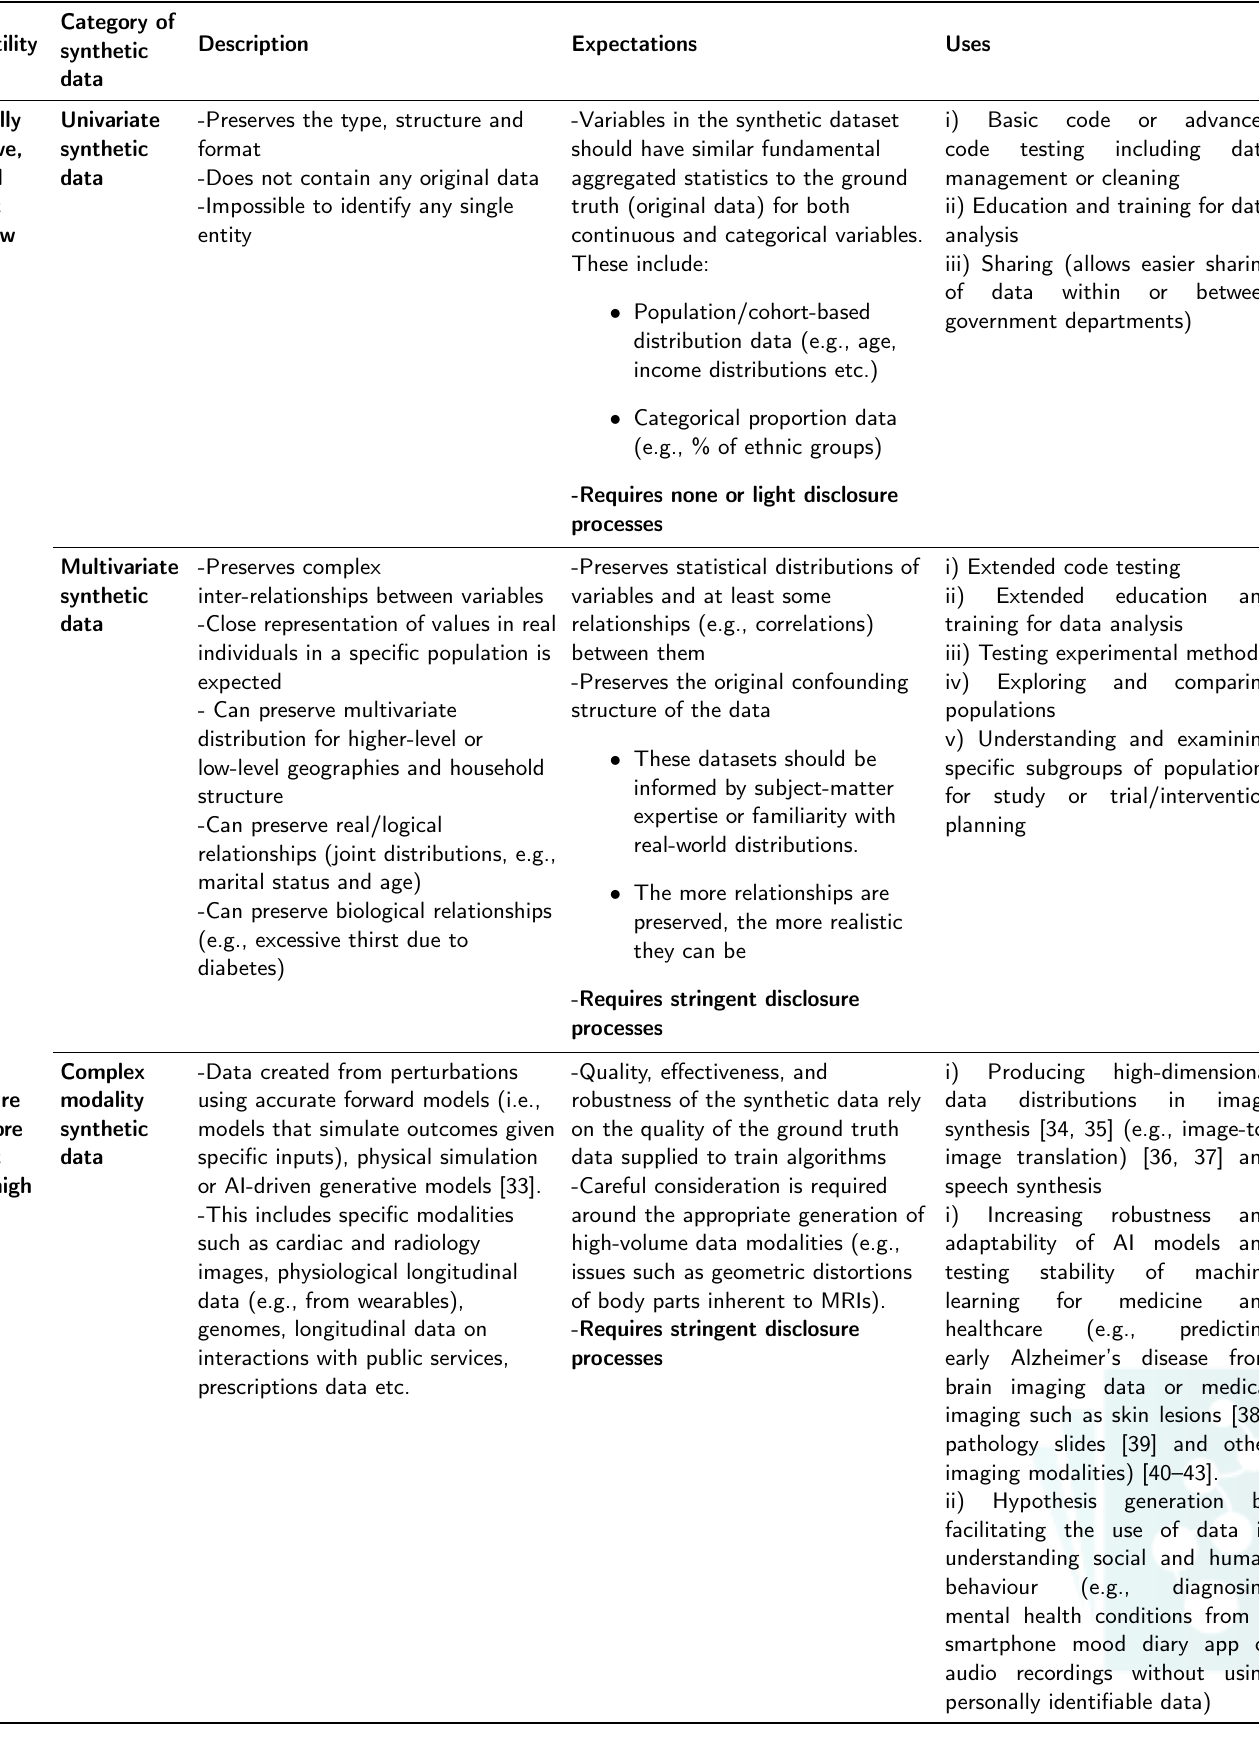
Table 1: Proposed simplified categorisation of synthetic data (a more comprehensive summary of existing terminology for synthetic data can be found in Supplementary Table